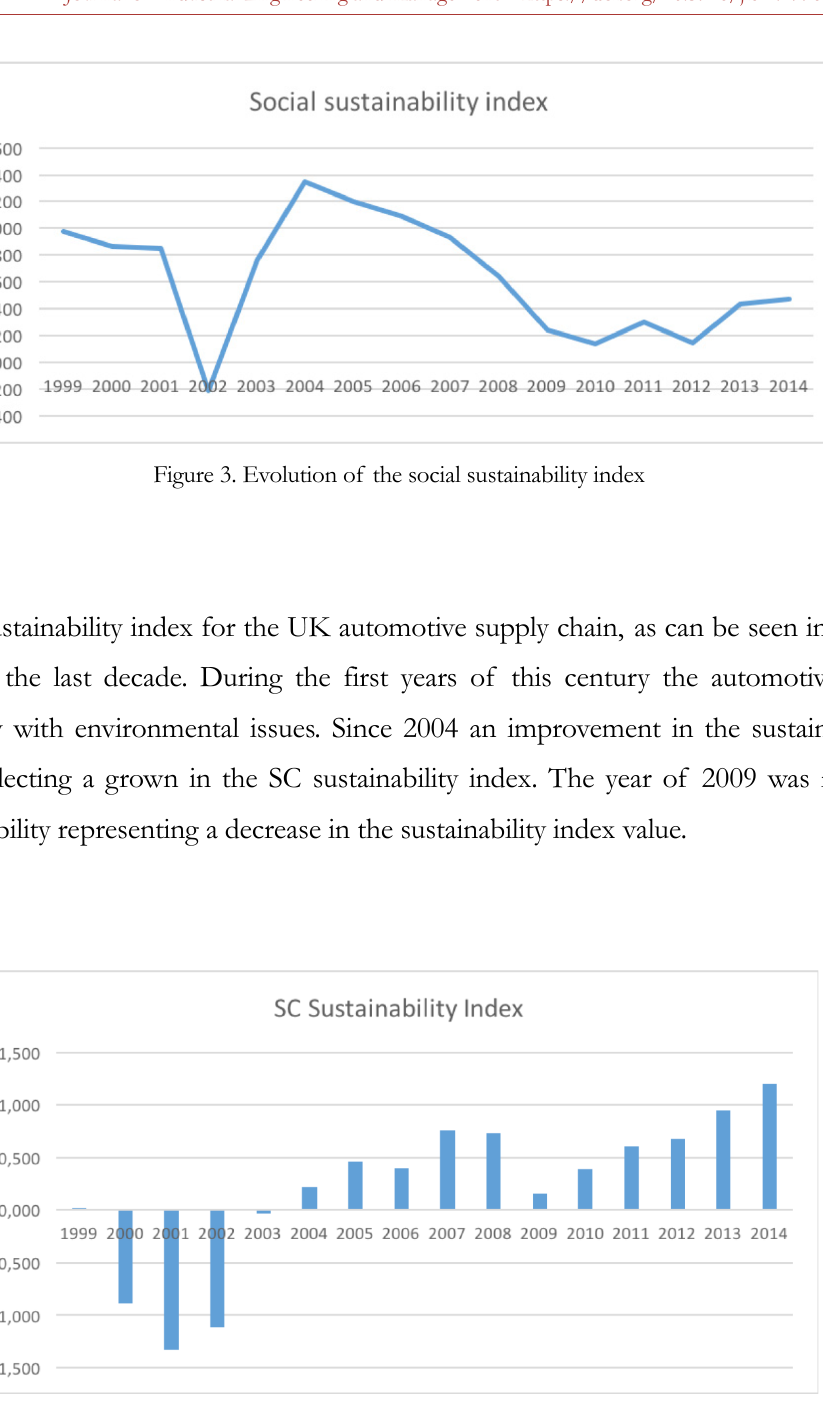
Figure 4. Evolution of the SC sustainability